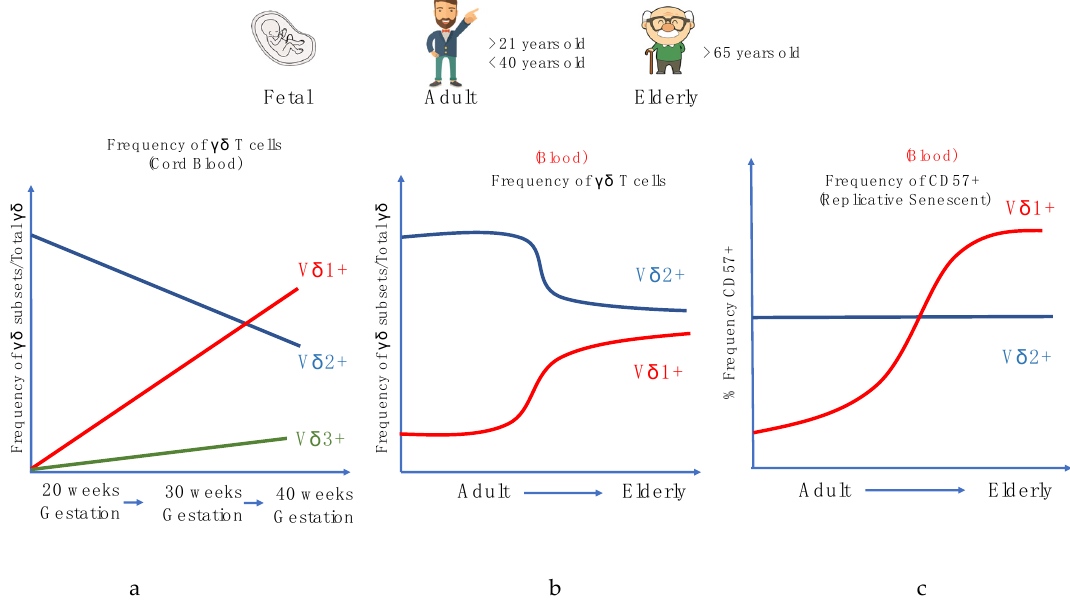
Figure 3. Alterations in human γδ T cells during development and aging. ( a ) Frequency of γδ subsets / Total γδ in the cord blood during gestational weeks, ( b ) Frequency of γδ subsets / total γδ in the periphery with age. ( c ) Frequency of CD57 + γδ cell populations in the periphery with age.